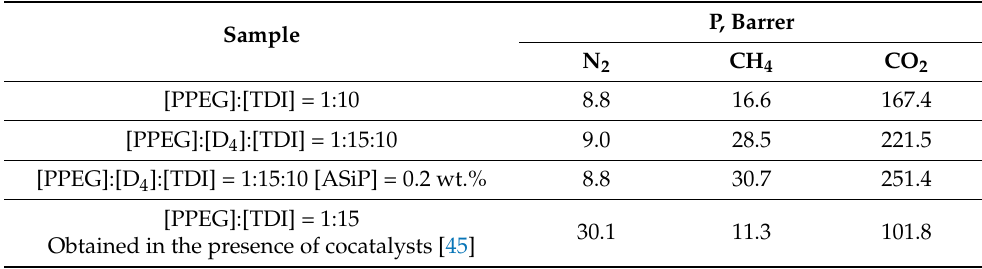
Table 2. Permeability coefficients.